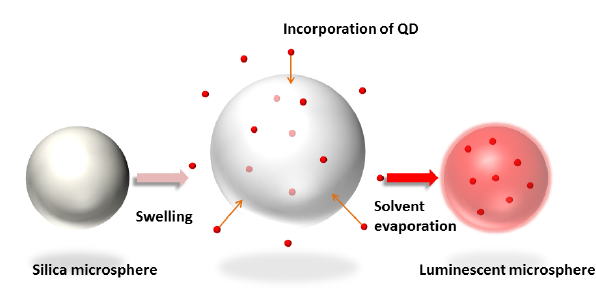
Figure 3: Schematic of incorporation of QDs to obtain luminescent microsphere. QDs: quantum dots.